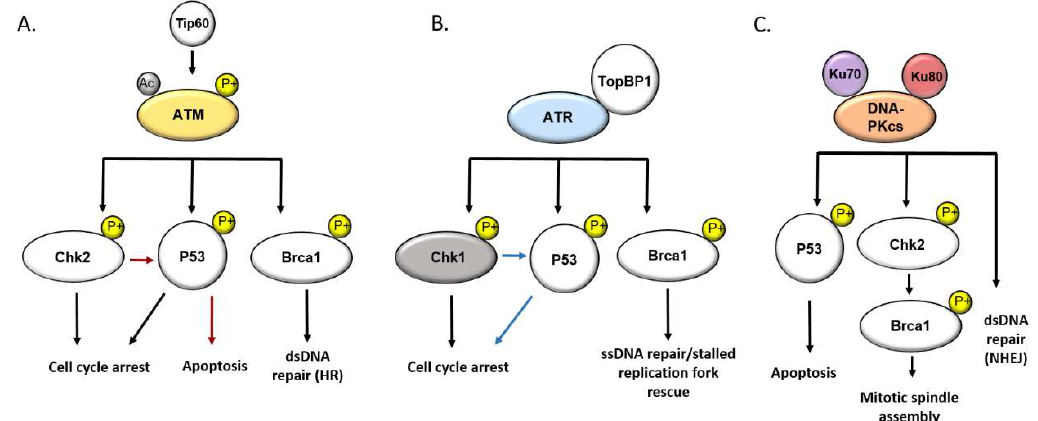
Figure 1. Simplified diagram of the dynamic and interconnected DNA damage response network orchestrated by the signal transducing kinases ATM, ATR, and DNA-PKcs: ( A ) Tip60 acetylates ATM at lysine residue 3016, resulting in auto phosphorylation and activation of ATM kinase monomers. ATM phosphorylation of Chk2 and P53 leads to induction of cell cycle arrest, while ATM phosphorylation of Brca1 initiates double stranded DNA repair through homologous recombination (HR). Chk2 phosphorylation of P53 independent of ATM leads to apoptosis. ( B ) ATR and TopBP1 localize to sites of DNA Damage and replicative stress, where ATR phosphorylates e ff ectors substrates. ATR mediated activation of Chk1 and P53 induce cell cycle arrest, while phosphorylation of Brca1 augments DNA end resection and single stranded DNA break repair by HR. Phosphorylation of P53 by activated Chk1 further augments cell cycle arrest. ( C ) DNA-PK stabilizes P53 in response to excessive genotoxic stress, inducing apoptosis. The ku70 and Ku80 subunits of the DNA-PK complex act as sca ff olding adaptors for DNA-PKcs and recruitment to dsDNA lesions, where DNA-PKcs facilitates DNA repair through the error prone non-homologous end joining pathway.